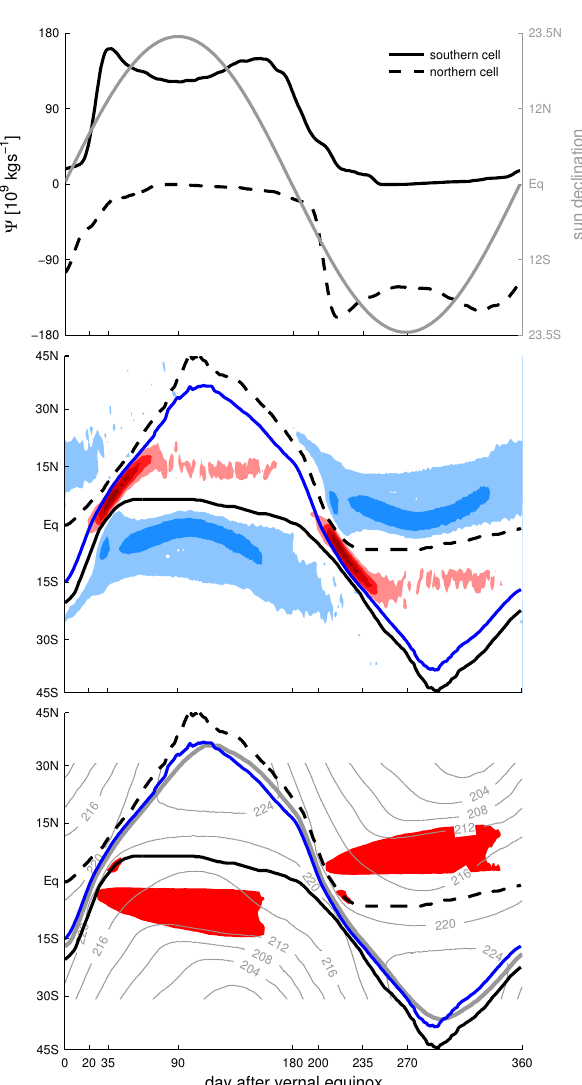
Fig. 6. Hadley circulation characteristics for seasonally vary- ing insolation. Top panel: strength of the southern and north- ern cell in units of 10 9 kgs − 1 . The sun declination in gray in- dicates the position of the sun. Middle panel: vertical mass flux W = − 2 π a cos ϕ ω at 800hPa in colored contours with contour in- g terval of 40 × 10 4 kgm − 1 s − 1 ; upward mass flux in red, downward mass flux in blue. Bottom: Potential temperature (gray contours) and its maximum (thick gray) at 900hPa. Regions with local Rossby numbers above 0.7 at 700hPa are shaded in red; note that regions in between 2 ◦ N/S are masked as the Coriolis parameter is zero at the equator. The black and blue lines in the middle and bottom figures track the center of the northern (black dashed) and the southern cell (black solid) and the boundary between the two (blue